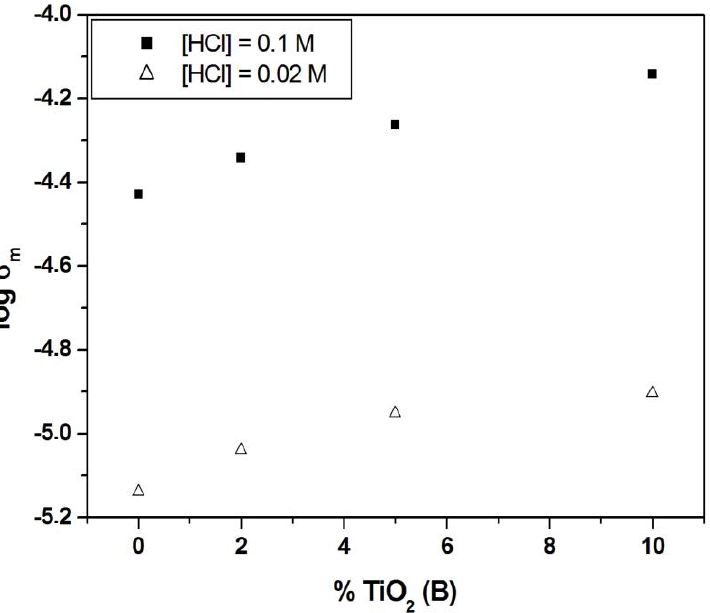
Figure 9. Ionic conductivity of sPSU and sPSU/x%TiO 2 (B) composite membranes (x = 2; 5 and 10) measured at room temperature ([HCl] = 0.02 M and [HCl] = 0.1 M).